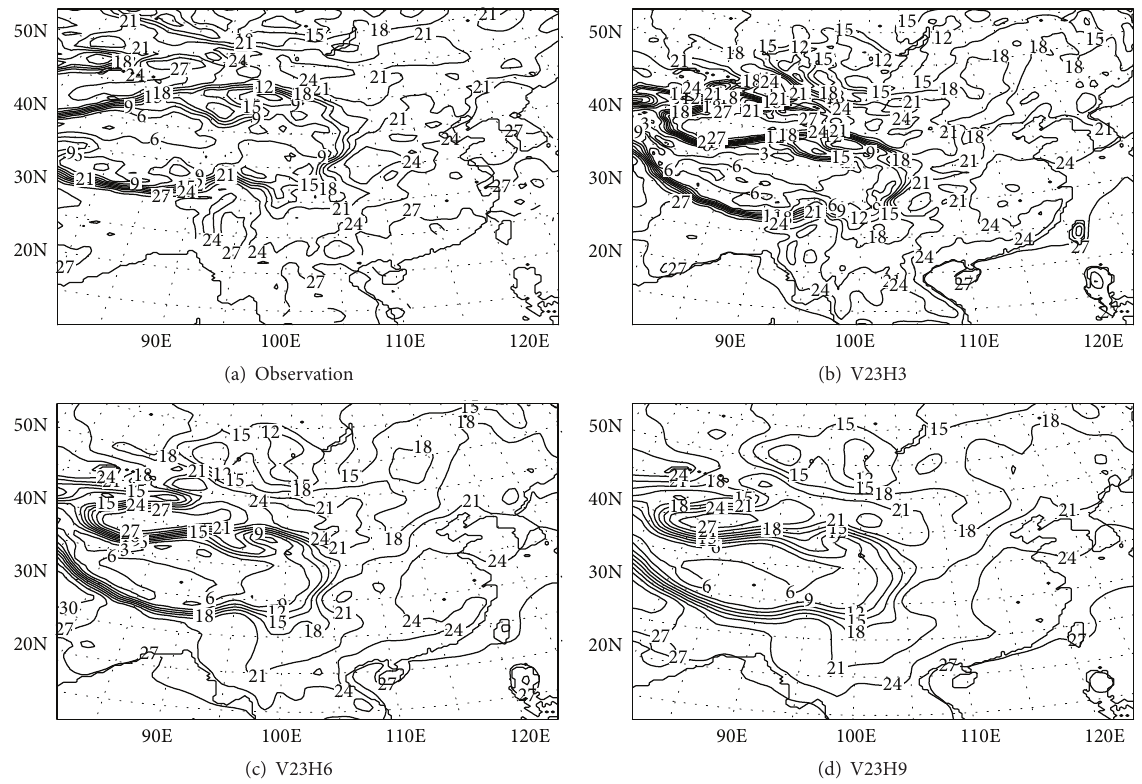
Figure 4: Summer-mean distribution of SAT from observations and simulations using Scheme V23 for (a) observations, (b) H3, (c) H6, and (d) H9 in ∘ C.